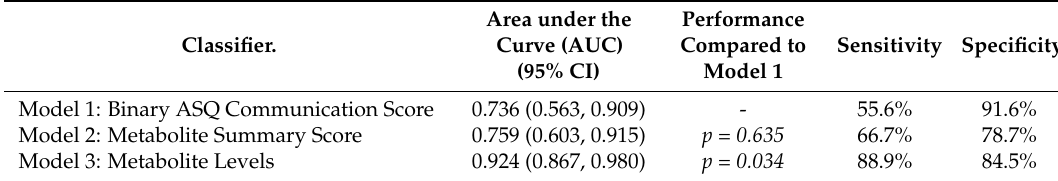
Table 4. Comparison of three different models for the prediction of autism by age